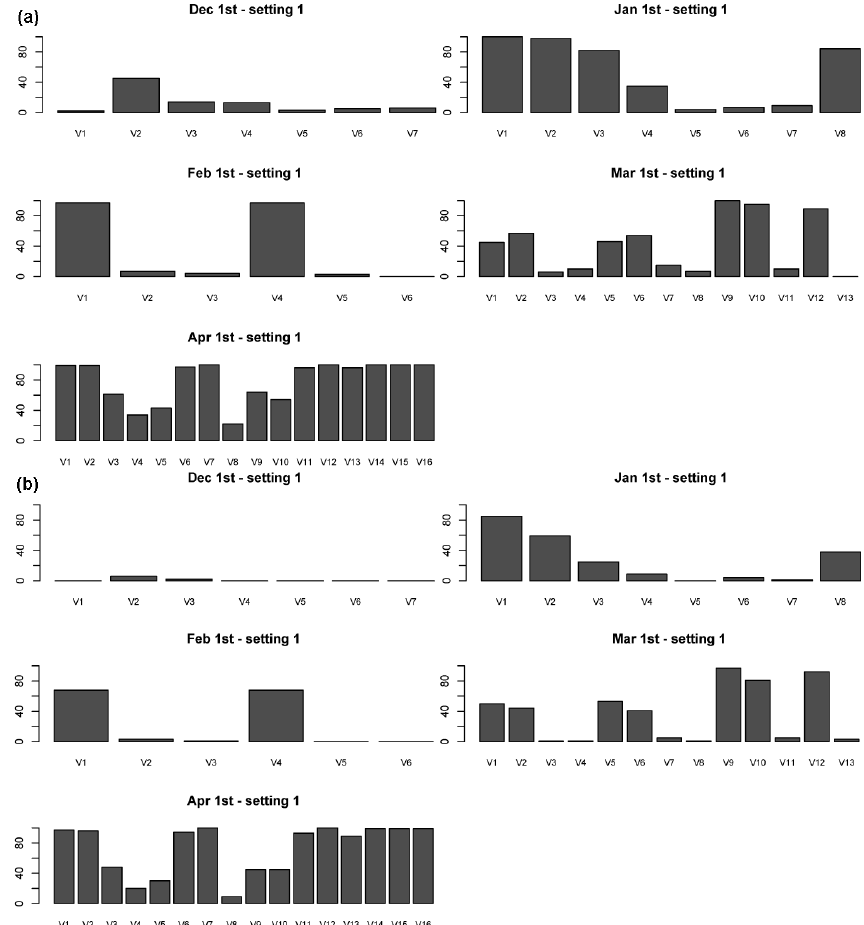
Fig. 5. (a) Number of times (in 100 iterations) the different variables were selected in setting 1 when AIC was used. V 1 to V p names are listed in Table 4; (b) same as (a) but when BIC was used; (c) number of times (in 100 iterations) different variables were selected in setting 2. V 1 to V p names are listed in Table 4; (d) same as (c) but when BIC was